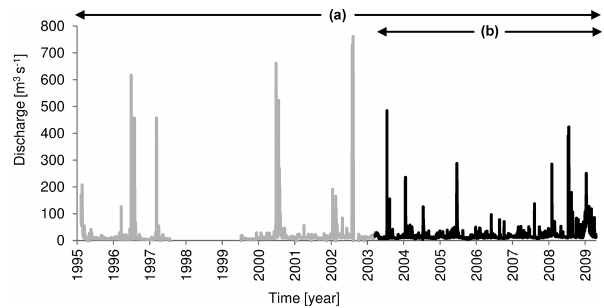
Figure 2. (a) 1 June 1995–31 December 2009 hourly discharge series used for the scenarios runs; (b) hourly discharge series measured at Belluno gauge station used for the calibration run (5 July 2003–5 August